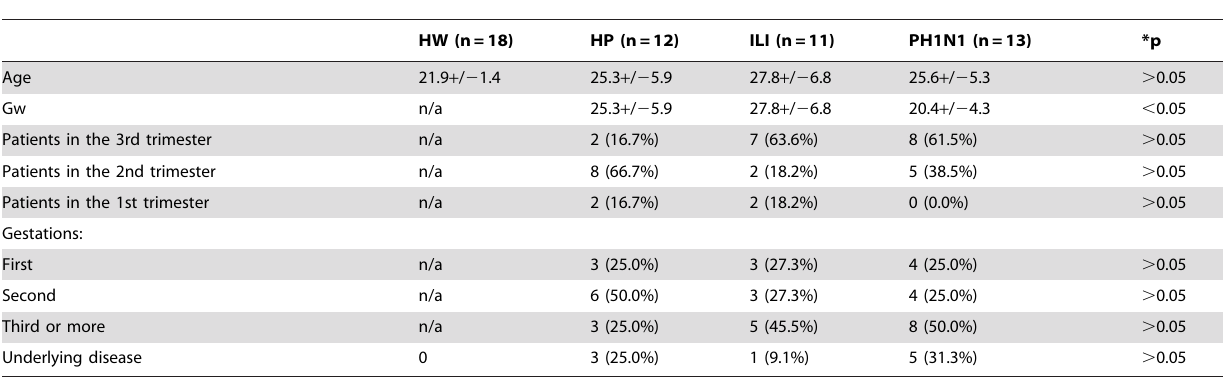
Table 1. Demographic and obstetric characteristics of the study population.